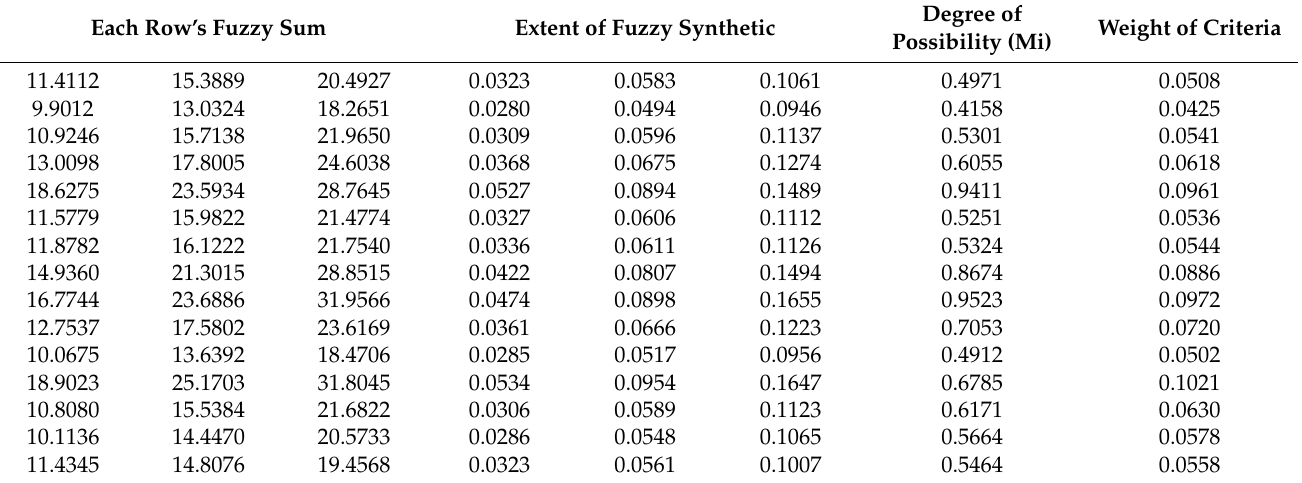
Table 2. Weight of